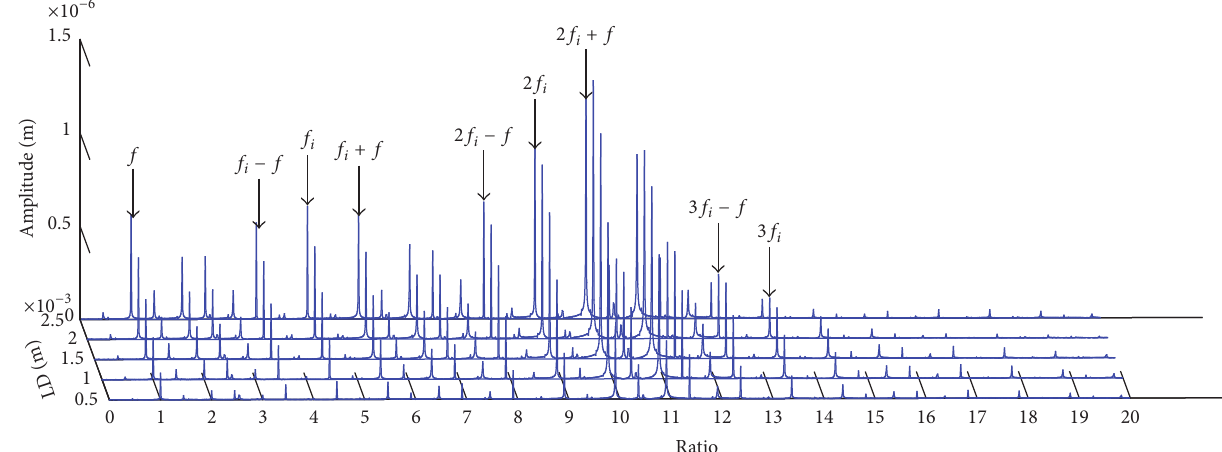
Figure 10: Waterfall plot of inner race defect bearing system with width of defect at